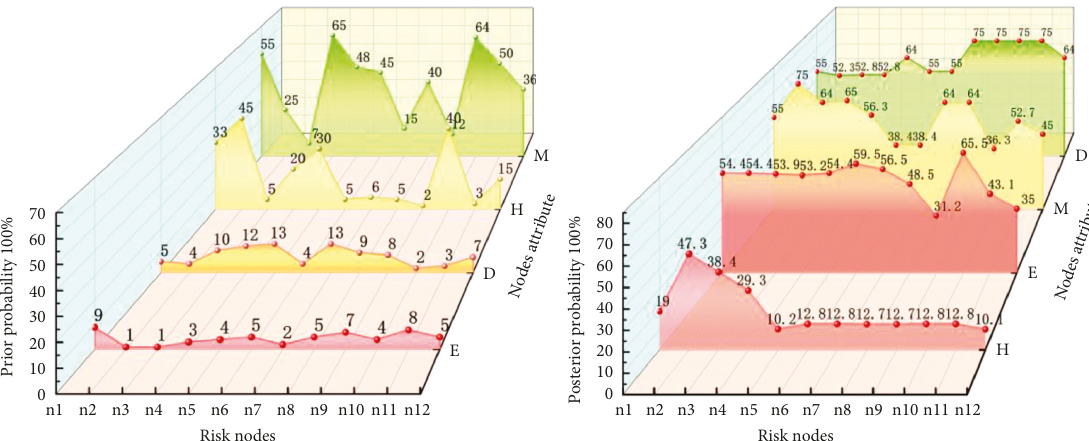
Figure 5: Prior probability and posterior probability